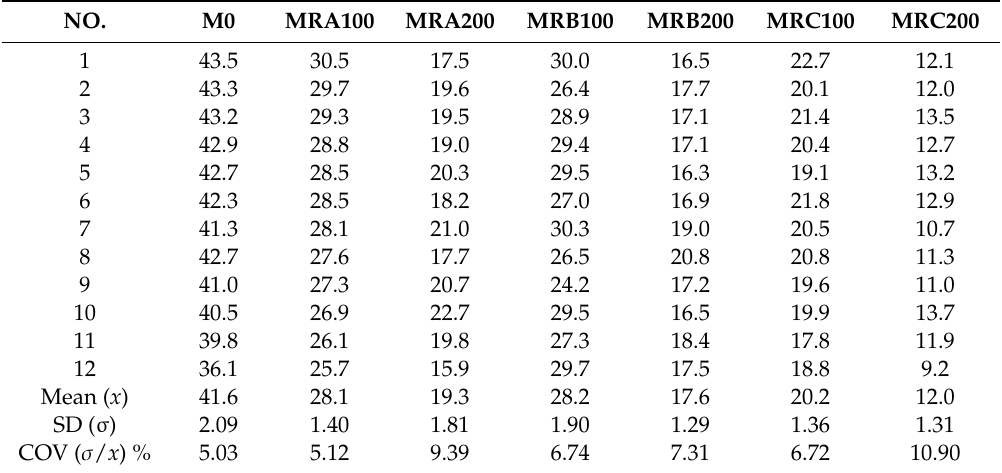
Table 5. Compressive strength of mortars (MPa).